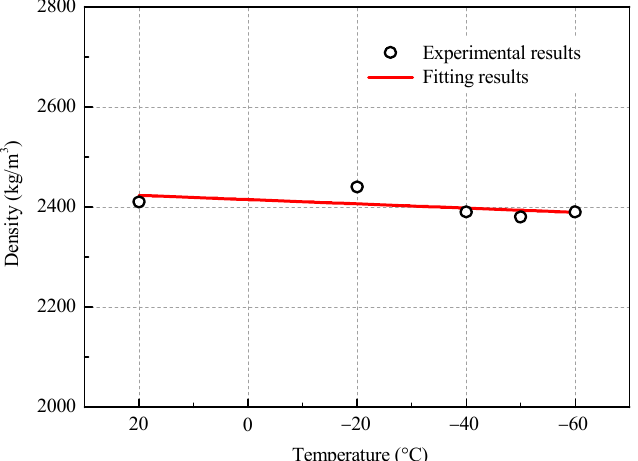
Figure 3. Variation of density with freezing temperature.